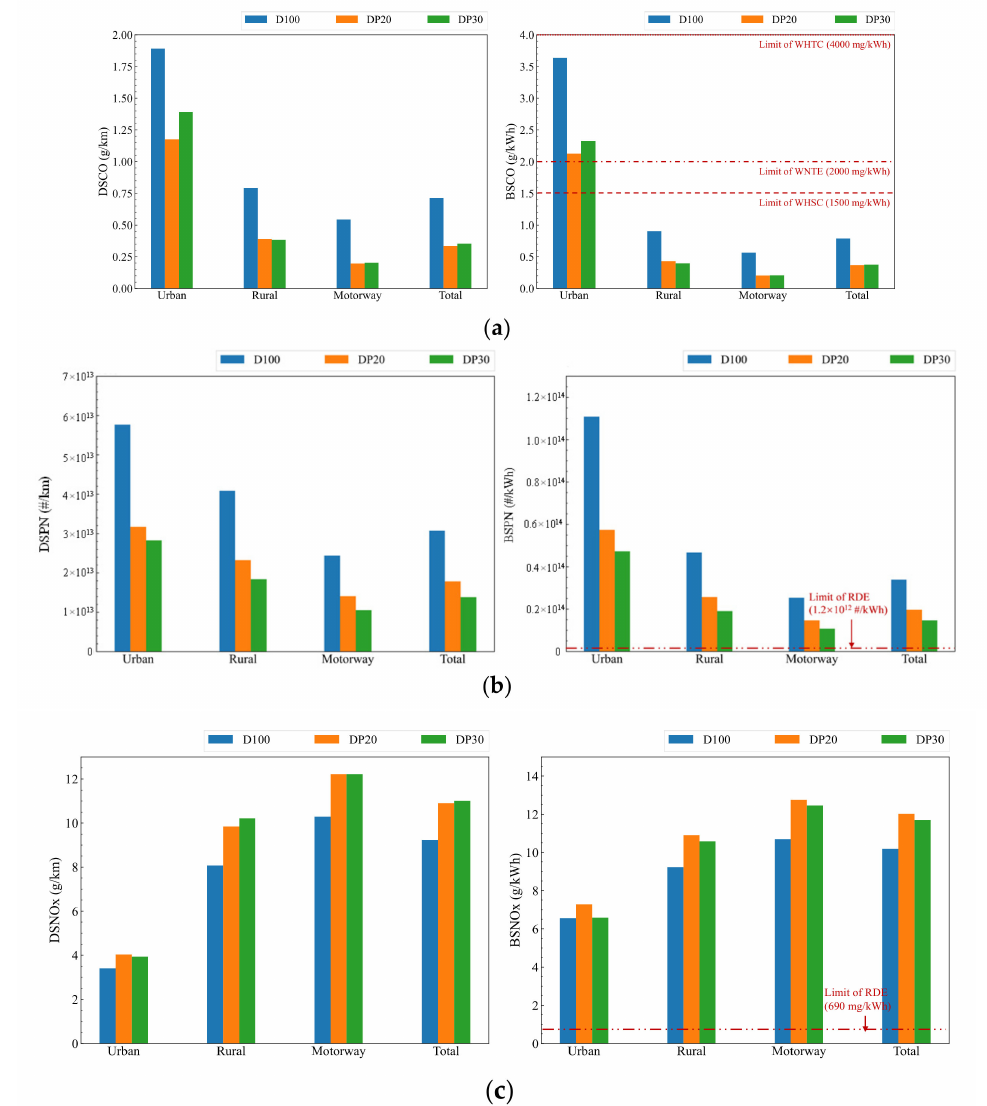
Figure 12. Comparison of distance-specific and brake specific ( a ) CO, ( b ) PN and ( c ) NOx